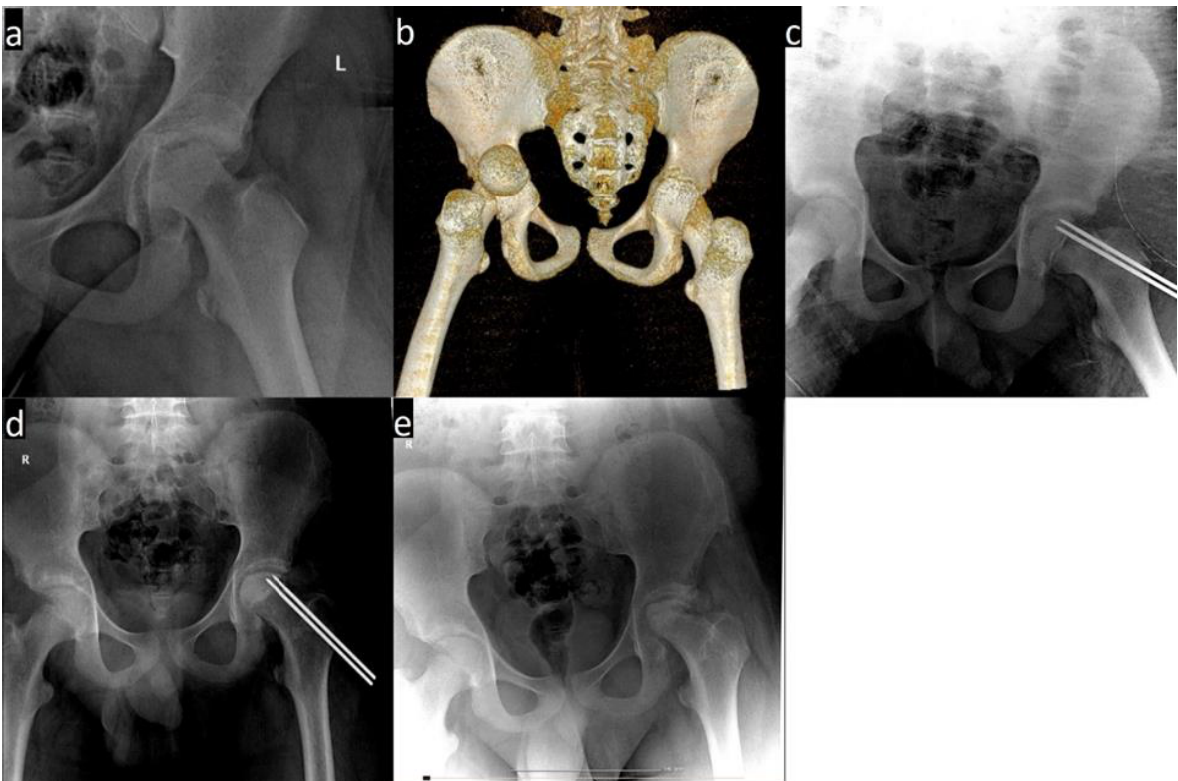
Figure 2. ( a ) X-ray showing a dislocation of the left hip associated with a transphyseal fracture. ( b ) Left hip fracture dislocation on a CT image. ( c ) Postoperative X-ray. ( d ) Signs of femoral head necrosis 5 months after surgery. ( e ) AP view of the hip 1 year after trauma.